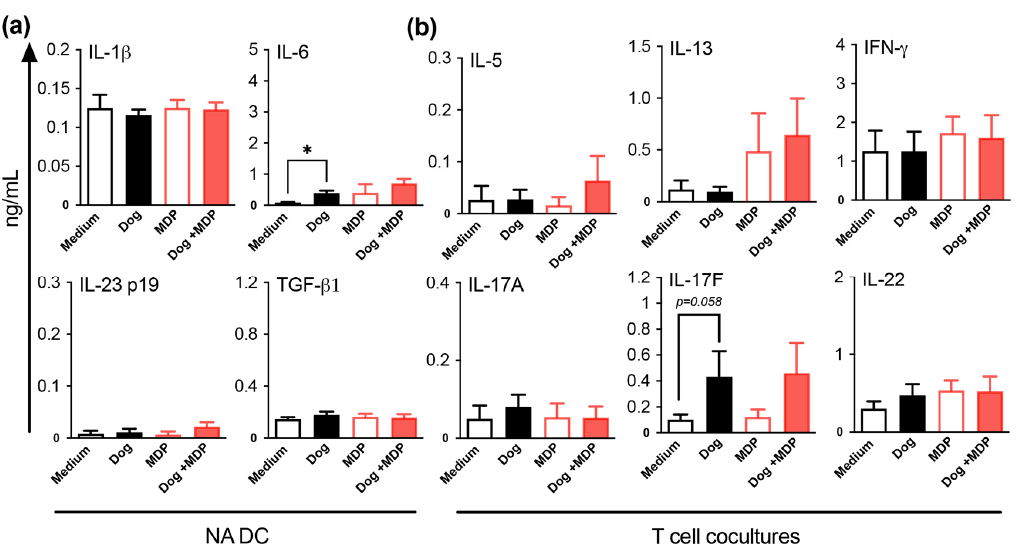
Figure 7. MDP co ‐ stimulation of DC from NA subjects does not alter DC cytokine production and T cell polarization. ( a ) Cytokine profile of DC supernatants quantified by ELISA. ( b ) Cytokine profile of DC/T cell supernatants evaluated after 5 days of co ‐ culture by ELISA. Data are presented as mean ng/mL ± SEM for n = 8–10 NA subjects. * p < 0.05 versus medium. Friedman test for